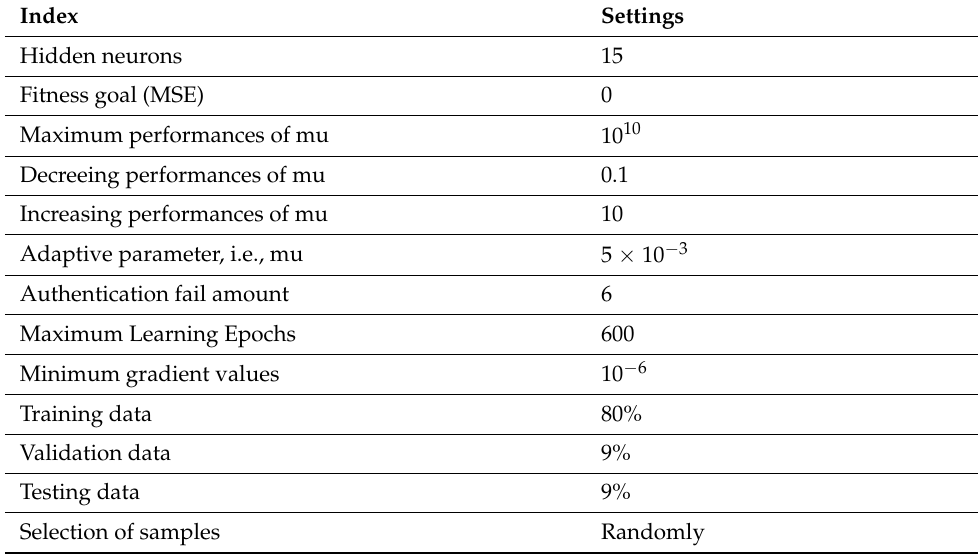
Table 1. Parameter setting to execute the SCGNNs